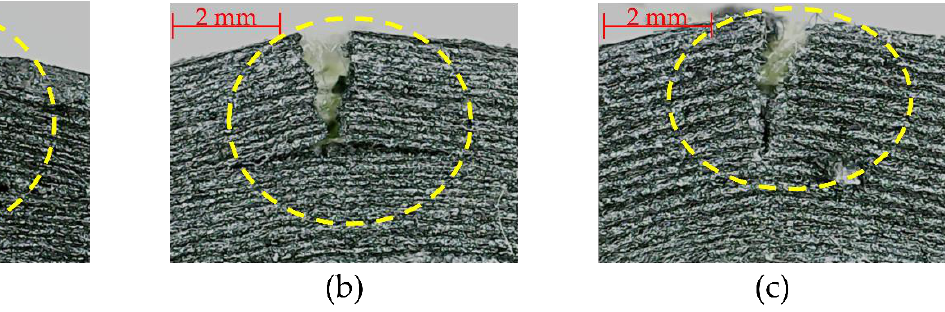
Figure 8. Bending failures in Onyx™–Kevlar ® composites: ( a ) matrix breakage, ( b ) delamination and ( c ) crack propagation. The areas with failures are marked within the yellow dotted circle.